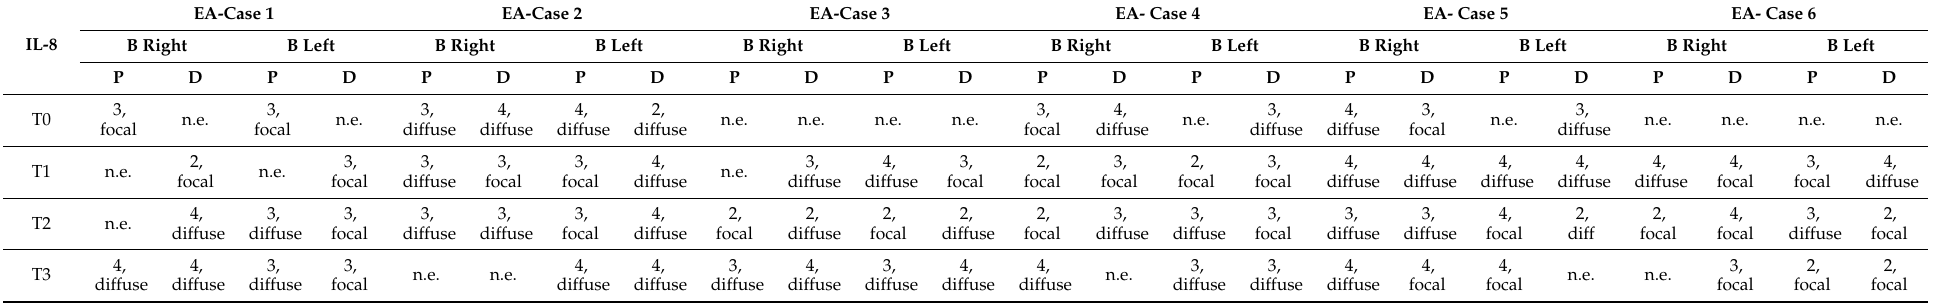
Table 5. Results of immunohistochemical evaluation to IL-8 of all endoscopic samples in the six EA-affected horses in all phases of experimental trial (T0, T1, T2, T3).